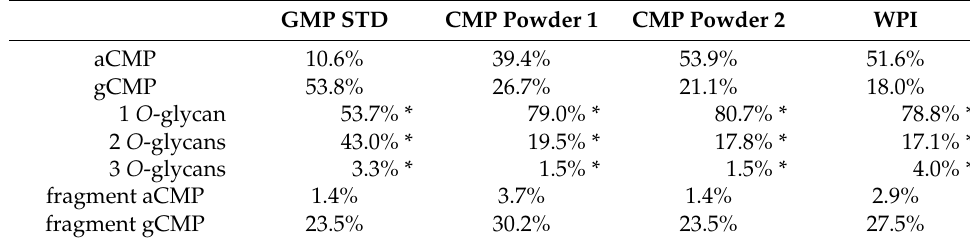
Table 2. The relative abundances of aCMP, gCMP, fragment aCMP and fragment gCMP in the four samples (CMP STD, CMP powder 1, CMP powder 2 and WPI). Abundances marked with * are the relative abundance of the 1 O -glycan, 2 O -glycans and 3 O -glycans within the intact gCMPs in the four samples.